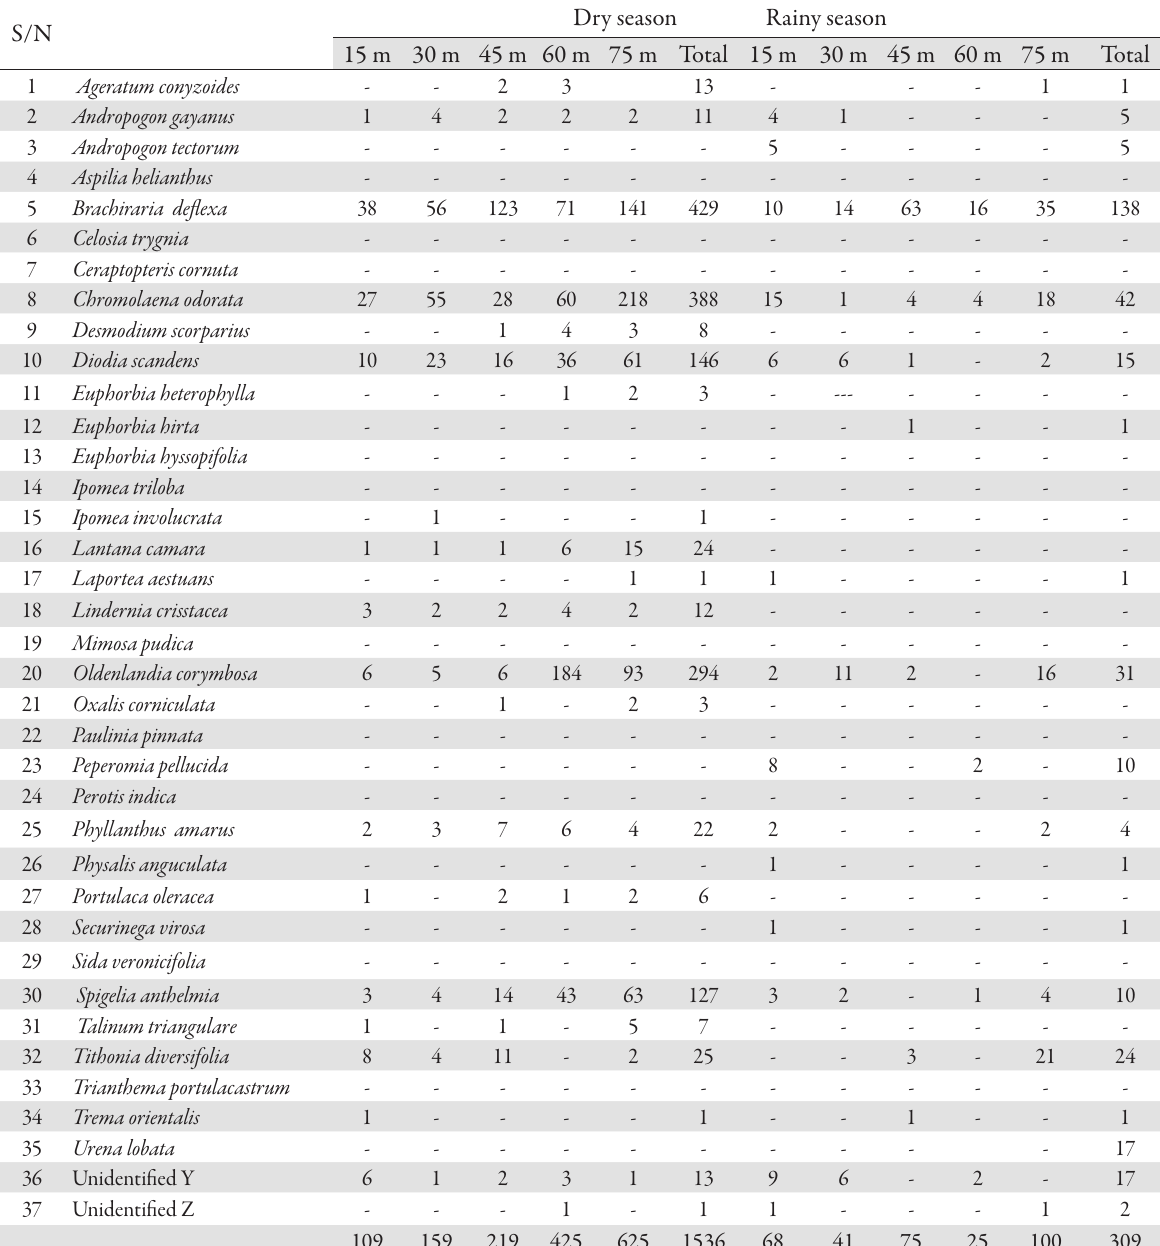
Tab. 5. Seedlings Emergence in relation to the extent of the fallowland in the study site 2 in both